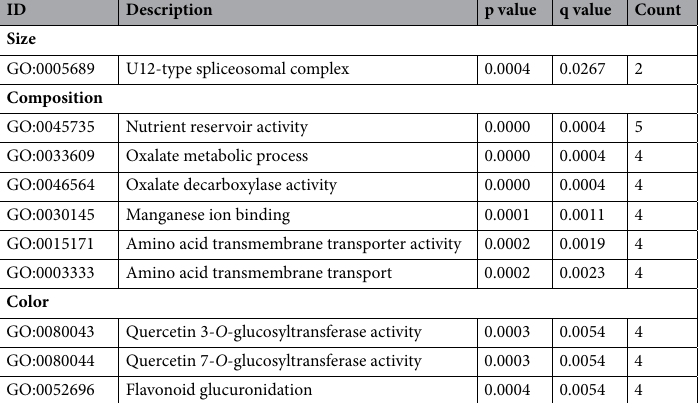
Table 2. Enrichment analysis of Gene Ontology (GO) terms on putative causal genes regulating different seed traits (i.e. size, composition and color). Enrichment p-values from hypergeometrical tests and q-values from Bonferroni corrections are indicated, as well as the number of genes annotated (count). Results were generated with R package